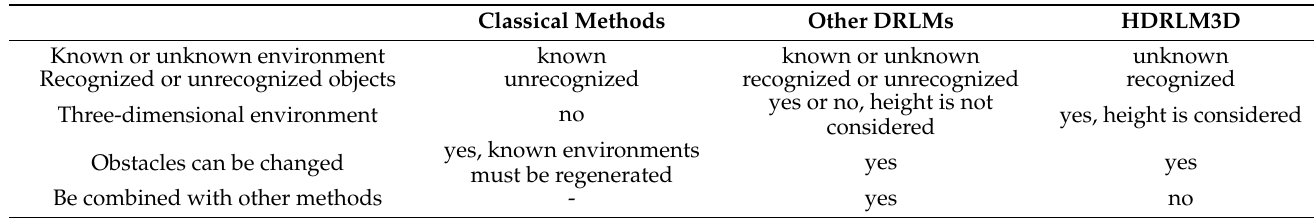
Table 7. Comparison of other methods and